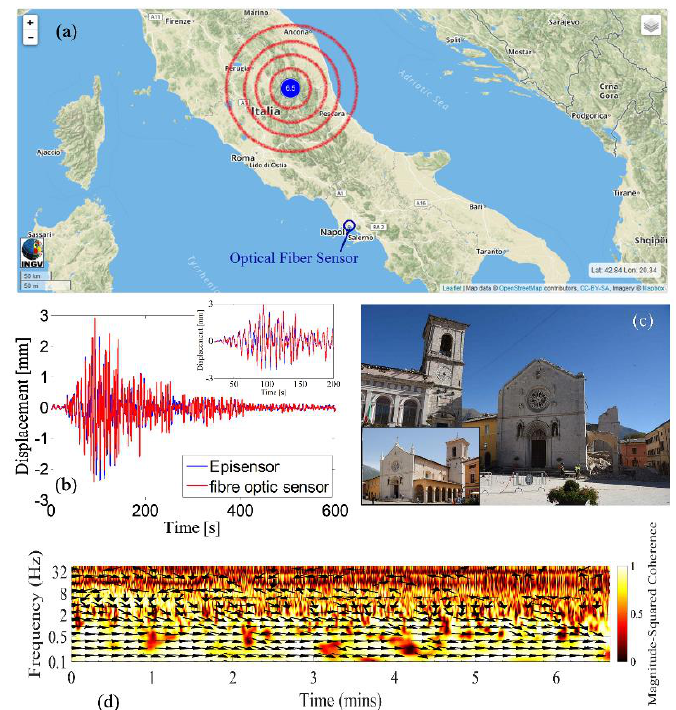
Figure 11. ( a ) Map of central Italy highlighting the Norcia earthquake epicenter and seismic station location (the map from http://cnt.rm.ingv.it/ was released under a CC-BY-SA license recordings of the LOF sensors and the reference sensor during the Norcia earthquake. ( c ) Photograph